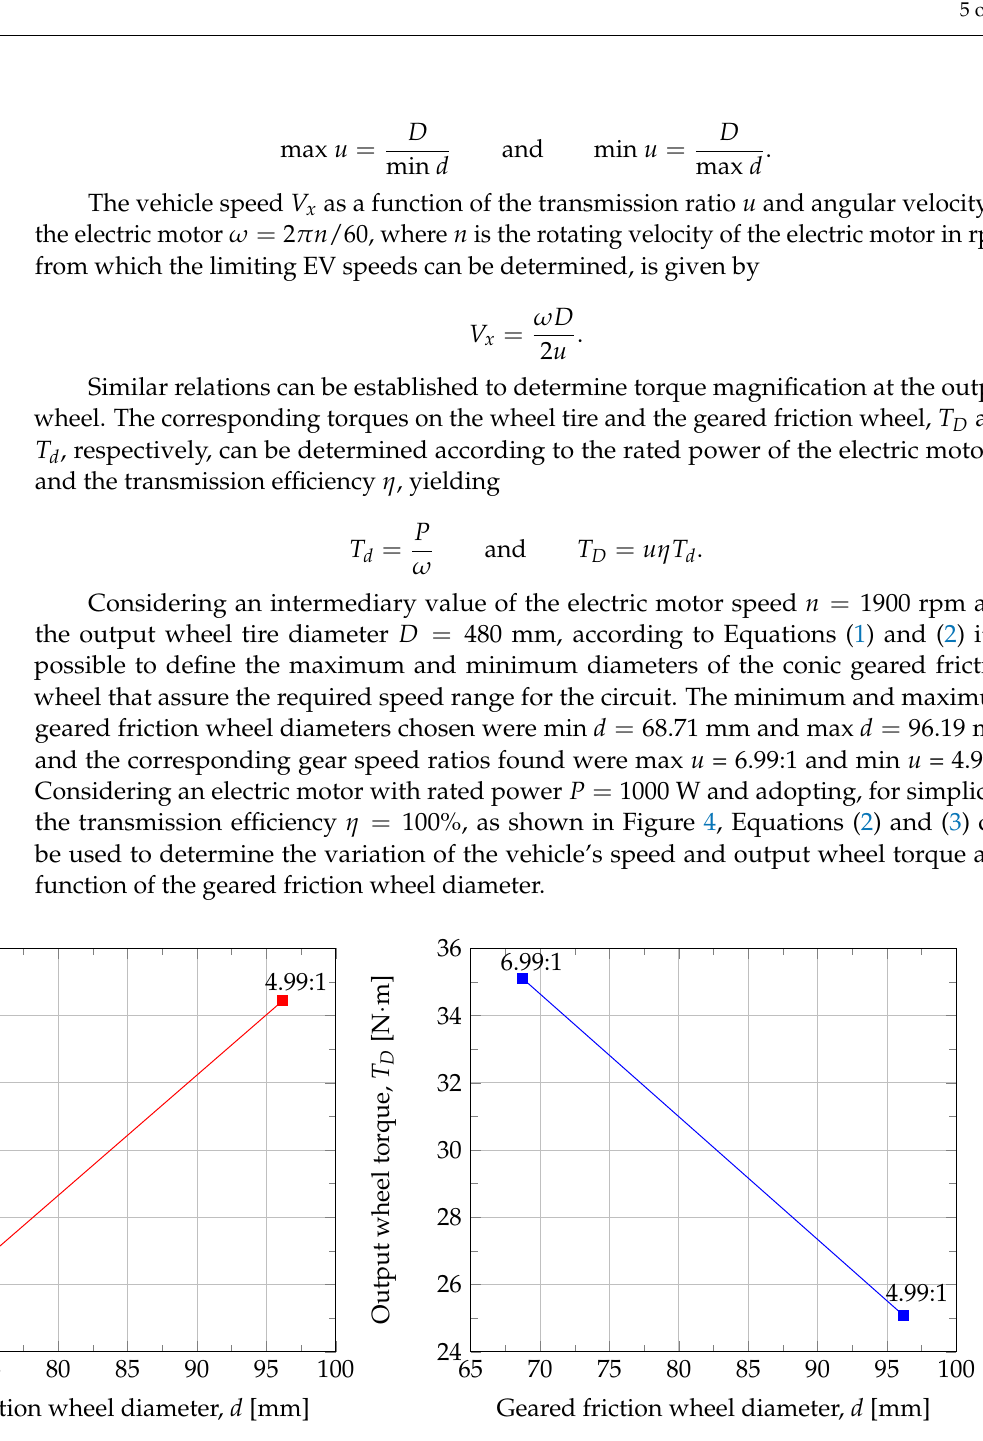
Figure 4. Vehicle output speed and output wheel torque as a function of the conic geared friction wheel diameter (transmission ratio); the CVT ranges from the value of u = 6.99:1 to u =